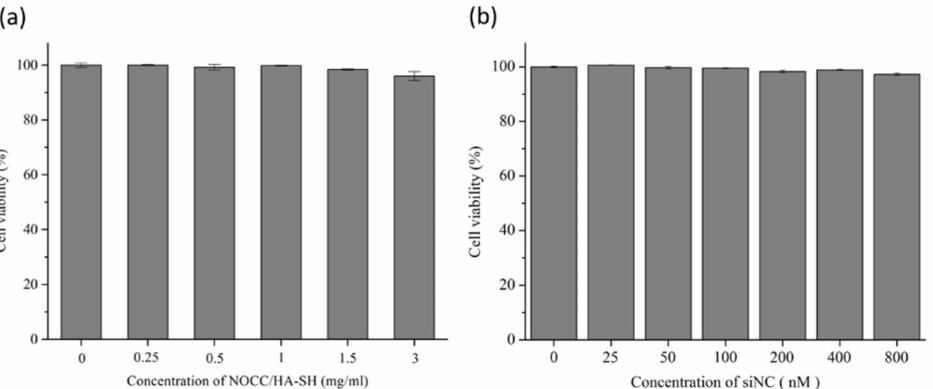
Figure 3. In vitro cytotoxicity of ( a ) NOCC/HA-SH and ( b ) SH-HA-Dopa-CaP/siNC to HeLa cells after 72-h incubation at 37 ◦ C and 5% CO 2 . The data are shown as means ± SD ( n = 3).